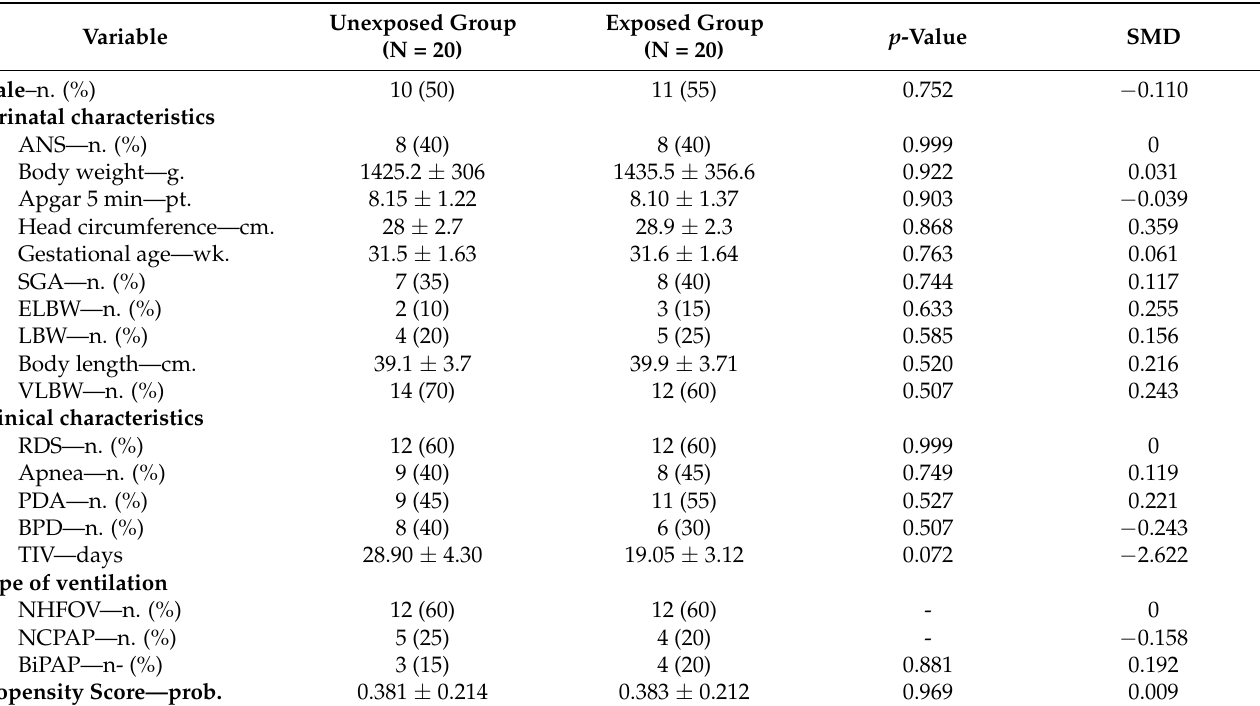
Table 1. Demographic and clinical characteristics of the included infants stratified by exposition to OMT. The balance between groups was tested with Student’s t-test and the chi-squared test as appropriate. Propensity score efficacy was tested with the standardized mean difference (SMD). Efficacy on balance between variables was set at SMD <